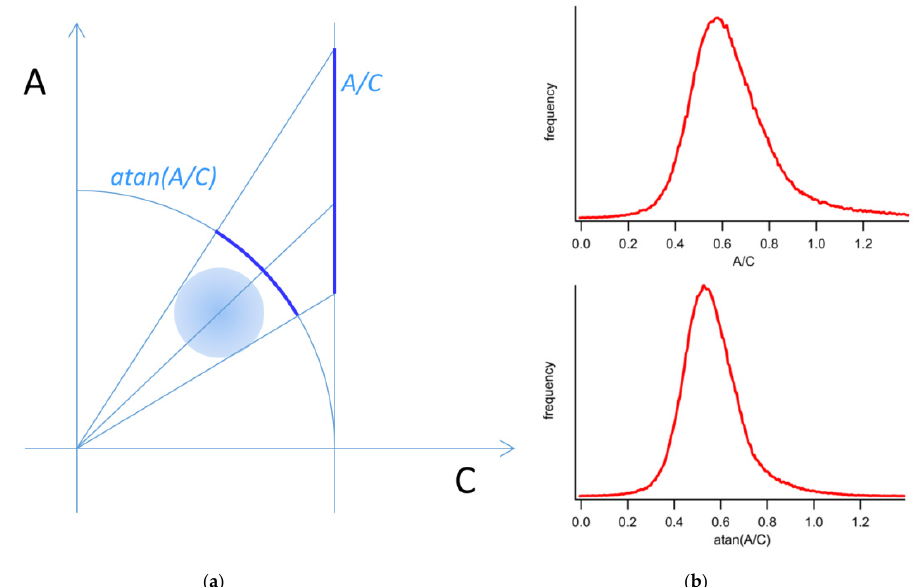
Figure A4. ( a ) Visual comparison between the use of the simple ratio A/C between components A and C , with its arctangent, atan(A/C) . The radial projection is linear on the circumference and distorted on its tangential line that represents the A/C ratio; ( b ) comparison of the histogram of the A/C and atan(A/C) for P04.